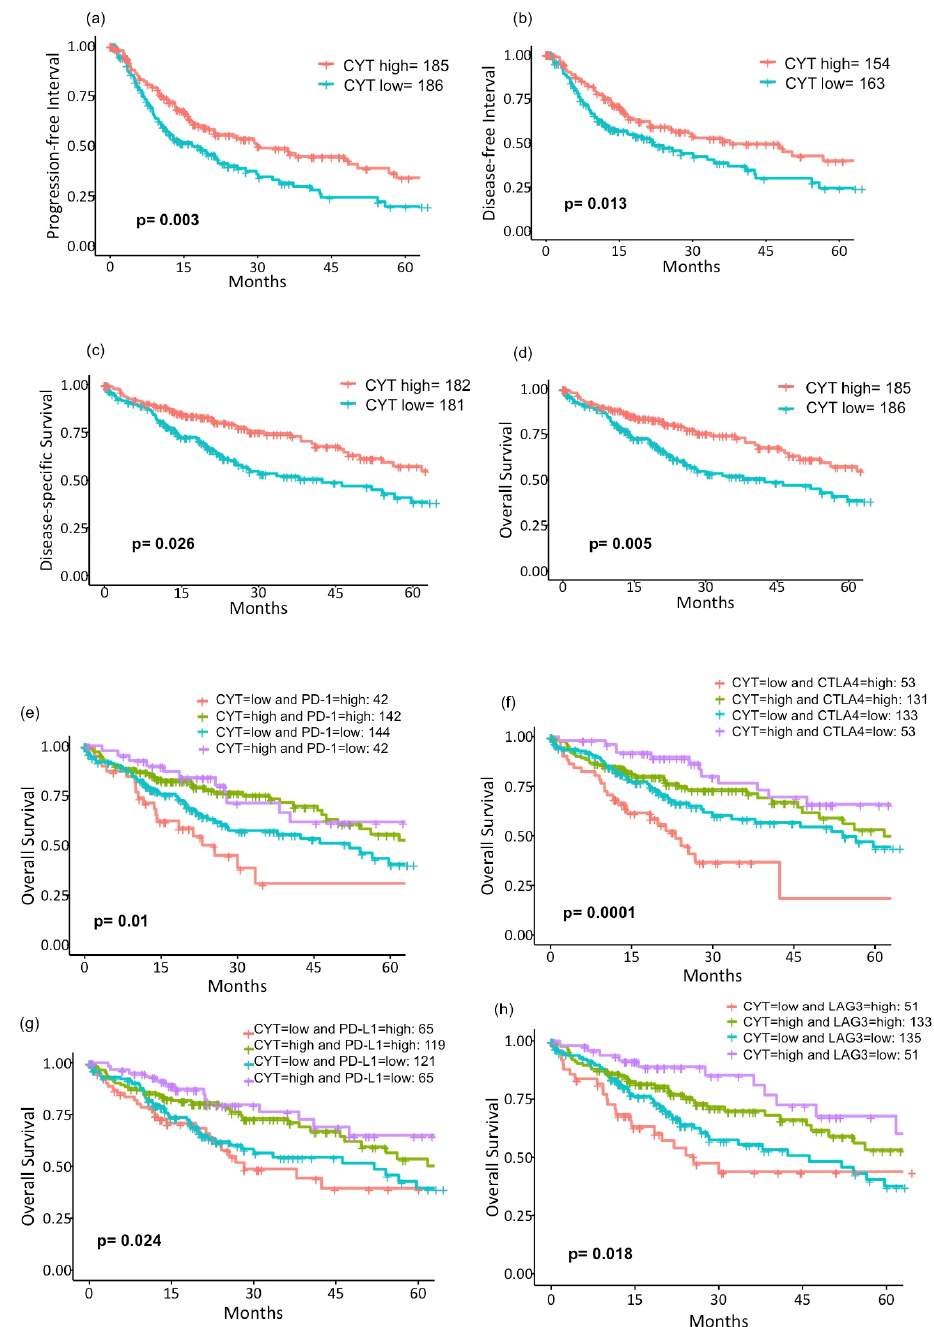
Figure 5. Survival analysis of the cancer genome atlas (TCGA) liver hepatocellular carcinoma (LIHC) patients. Kaplan-Meier curves of ( a ) PFI ( p = 0.003), ( b ) DFI ( p = 0.013), ( c ) DSS ( p = 0.026), and ( d ) OS ( p = 0.005) in CYT-high vs. -low patients. Survival curves of OS were further stratified by four major T cell exhaustion markers using the median value of each expression. ( e ) PD-1 ( p = 0.01), ( f ) CTLA4 ( p = 0.0001), ( g ) PD-L1 ( p = 0.024), and ( h ) LAG3 ( p = 0.018). Log-rank test was used to test group differences in survival analyses. CYT, cytolytic activity score; PFI, progression-free interval; DFI, disease-free interval; DSS, disease-specific survival; OS, overall survival; PD-1, program death-1; CTLA4, cytotoxic T-lymphocyte-associated protein 4; PD-L1, program death-ligand 1; and LAG3, lymphocyte-activation gene 3. Table 3. Univariate and multivariate analysis for the OS.